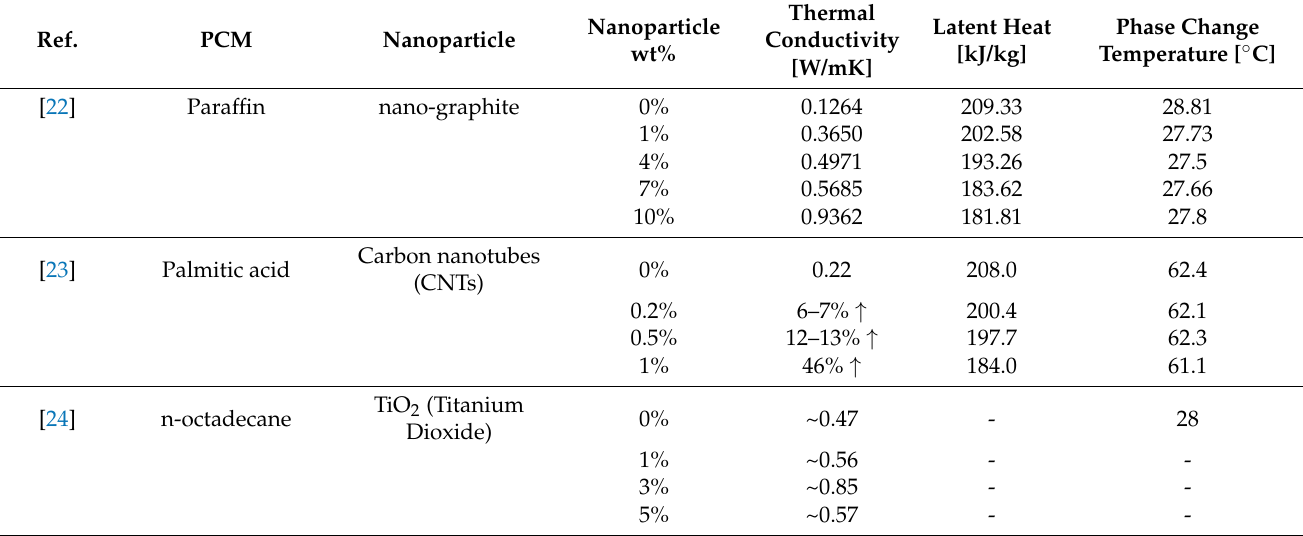
Table 2. Basic PCMs and their thermophysical properties before and after nano enhancement.